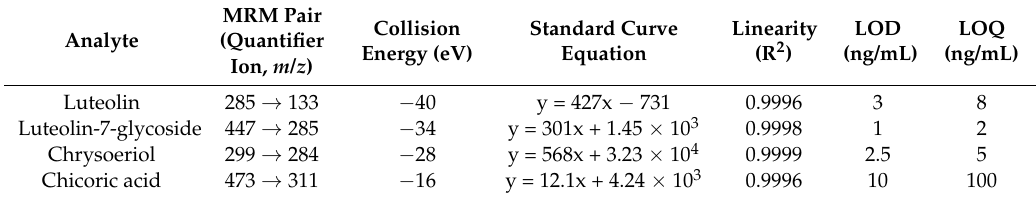
Table 5. Quantitative methods data.